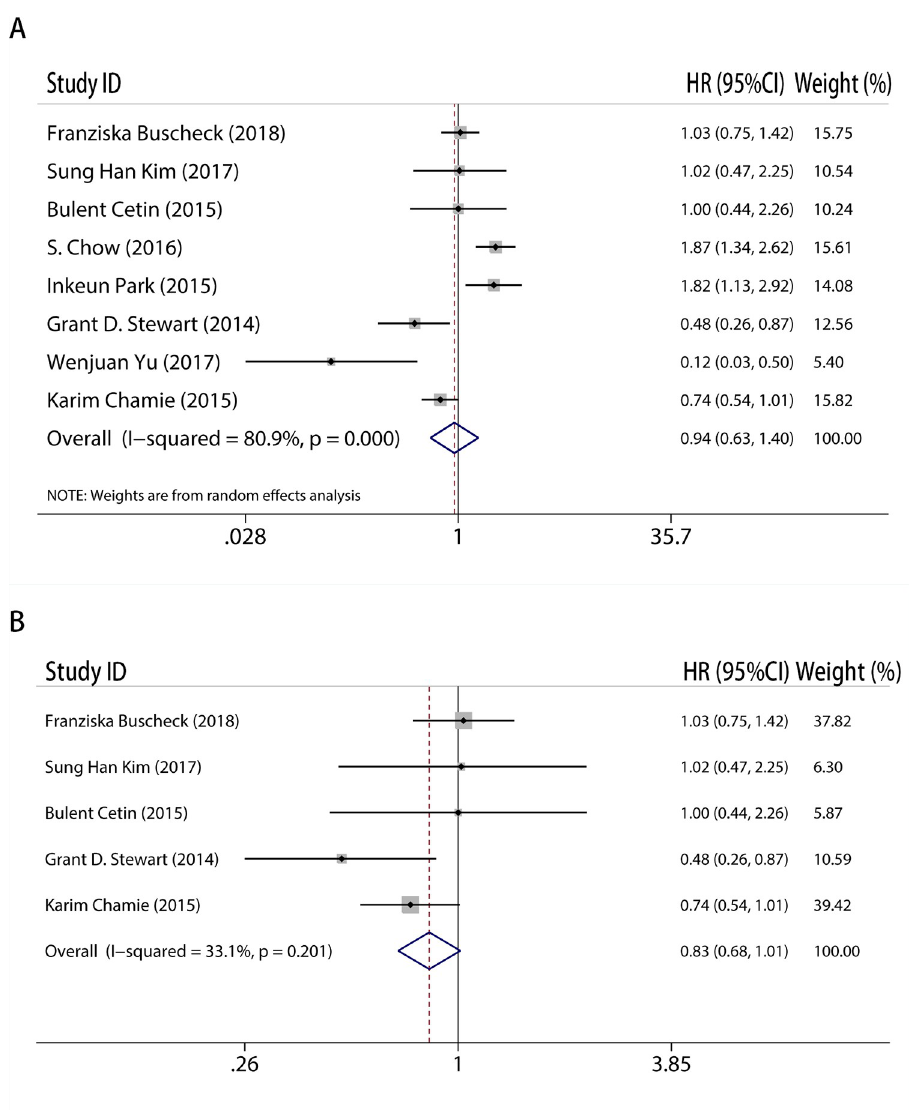
Fig 4. Meta-analysis of CAIX expression and overall survival on A, all new inclusion studies; B, by excluding the low quality score studies (quality score � 6).